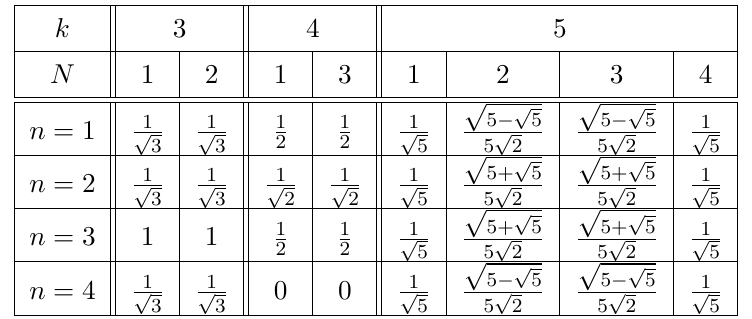
(cid:12) i(cid:12) h ˜ Z (cid:12) (cid:12) U ( N ) for 3 ≤ k ≤ 5 , 1 ≤ N ≤ k − 1 and 1 ≤ n ≤ 4 with (cid:12) (cid:12) k, 0